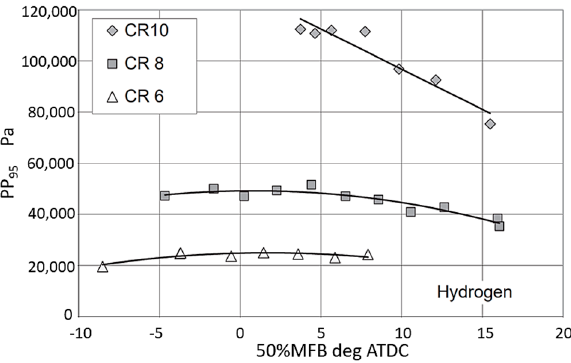
Figure 4. Knock intensity for 95th percentile of peak pressure vs. maximum rate of mass fraction burnt at various compression ratios (Szwaja [60]).